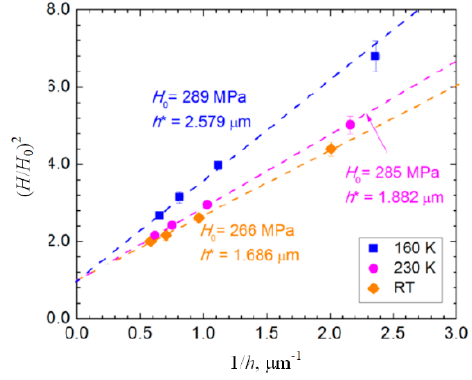
ff ect of (001) Al at RT and low temperatures Figure 19. Indentation size effect of (001) Al at RT and low temperatures [68]. Figure 19. Indentation size e